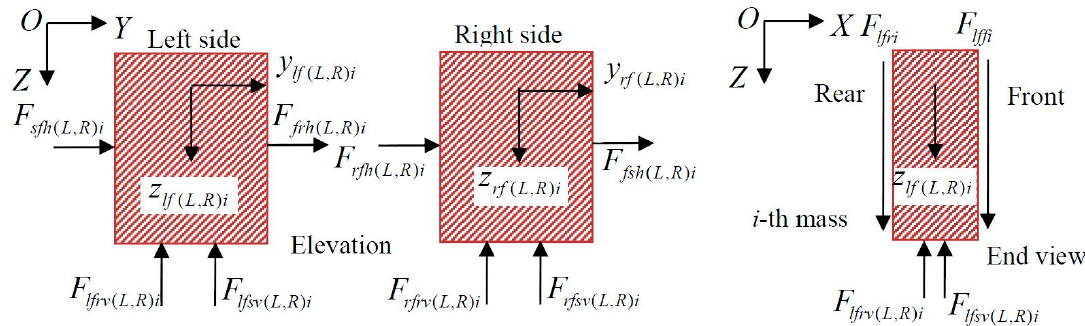
Figure 4. Dynamic model of elastomer in groove.